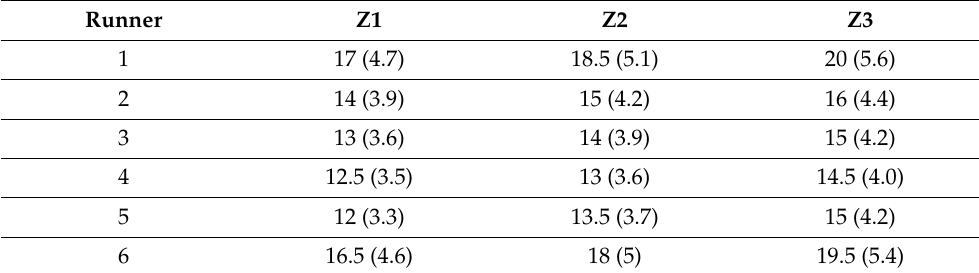
Table 2. Race paces in km/h (m/s) for each of the athletes, as specified by their coach. Runner